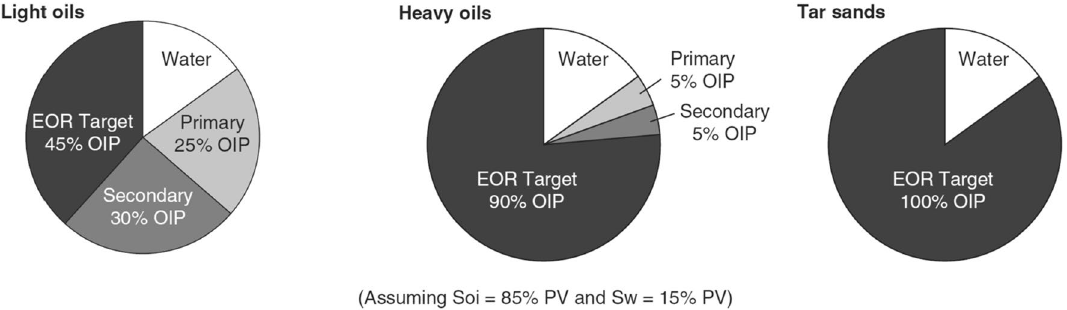
Fig. 1 EOR target for different oil reservoir types (Thomas